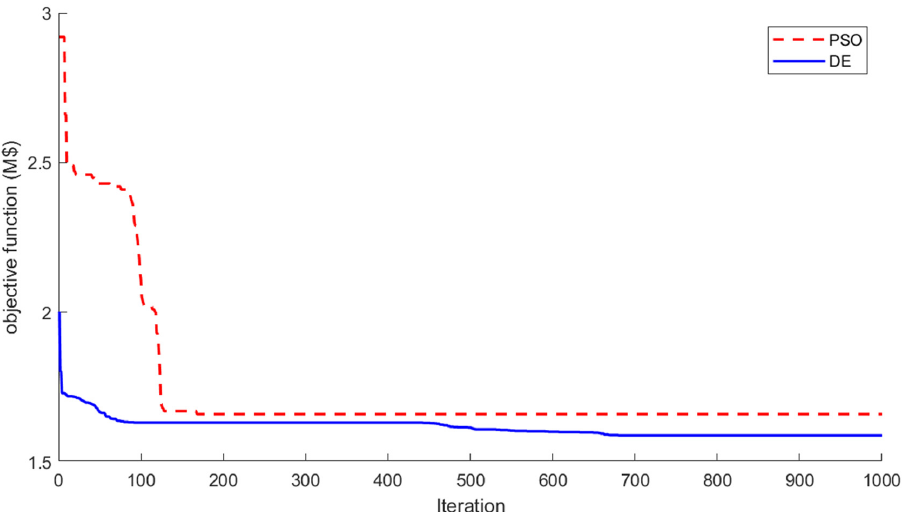
Figure 9. Convergence characteristics of the DE and PSO algorithms for case 1.